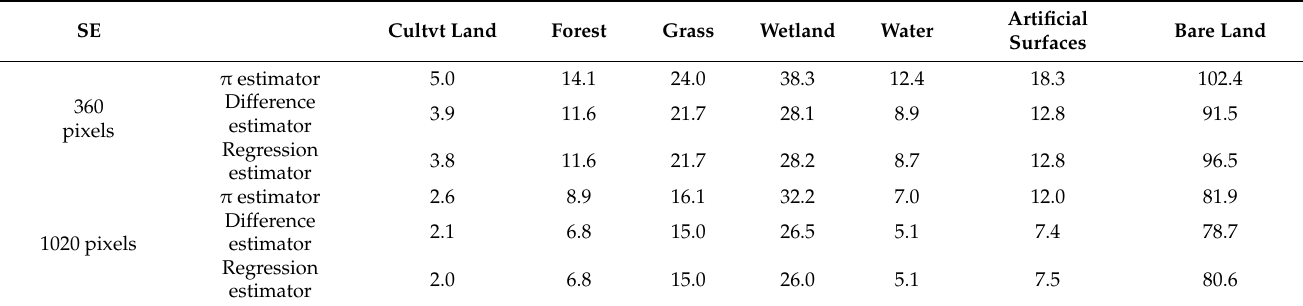
Table 4. Standard error (SE) estimates (relative to area proportions estimated) obtained with different estimators